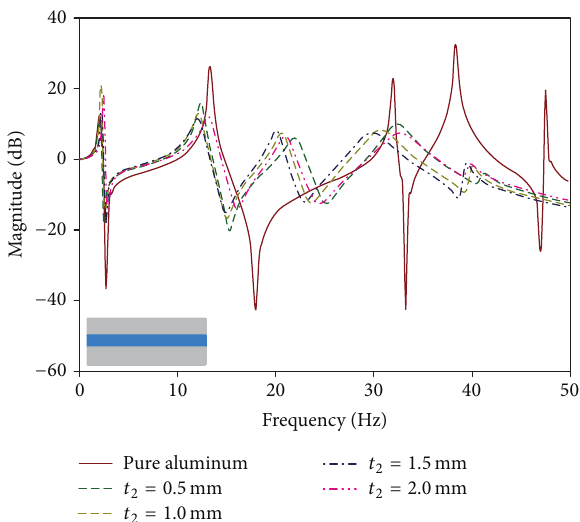
Figure 10: Frequency response of cylindrical aluminum panel in case of SSDL with variety of thicknesses of damping layer 𝑡 2 ( 𝑎 = 0.2 m, 𝜙 = 0.01 rad, 𝑅 = 20 m, 𝑡𝑎 = 10 mm, 𝑡 and 𝜂 = 0.1